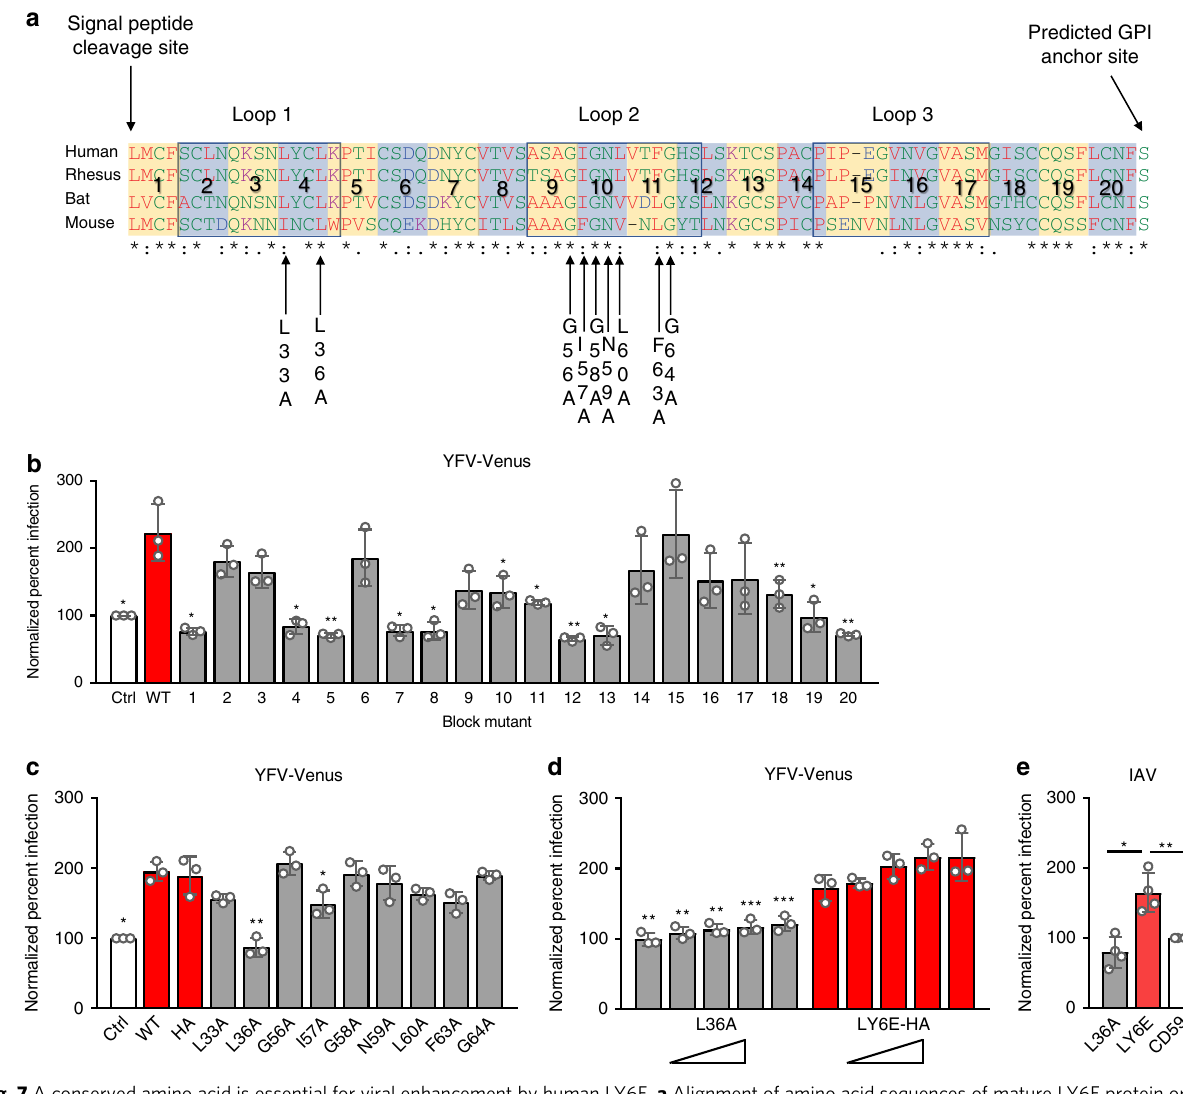
Fig. 7 A conserved amino acid is essential for viral enhancement by human LY6E. a Alignment of amino acid sequences of mature LY6E protein orthologs. Red residues (AVFPMILW): small and hydrophobic or aromatic (except Y); blue residues (DE): acidic; magenta residues (RK): basic (except H); green residues (STYHCNGQ): have hydroxyl, sulfhydryl, or amine groups (plus G). Hyphens (-) indicate absence of a residue presents in other sequences. Consensus symbols indicate the following: *(asterisk) indicates a single, fully conserved residue, :(colon) indicates conservation between groups of strongly similar properties, .(period) indicates conservation between groups of weakly similar properties. b STAT1 -/- fi broblasts expressing LY6E block mutants as shown in ( a ), WT LY6E, or fl uc control were infected with YFV-17D-Venus (0.33 MOI, 24 h, control average 33% infection). Infection is shown normalized to fl uc control. n = 3 biological replicates. c STAT1 -/- fi broblasts expressing HA-tagged LY6E point mutant clones as shown in ( a ), LY6E-HA, or fl uc control were infected with YFV-17D-Venus (0.25 MOI, 24 h, control average 16.4% infection). Infection is shown normalized to fl uc control. n = 3 biological replicates. d STAT1 -/- fi broblasts were transduced with fi ve volumes of lentivirus (twofold increase per dose) expressing LY6E(L36A)-HA, LY6E- HA, or fl uc control. Cells were infected with YFV-17D-Venus (0.25 MOI, 24 h, control average 24% infection). Infection is shown normalized to fl uc control (not shown) for respective lentivirus doses. n = 3 biological replicates. e STAT1 -/- fi broblasts expressing LY6E, LY6E (L36A), or CD59 were infected with IAV (A/WSN/33, 0.25 MOI, 8 h, control average 17.4% infection) and stained for NP. Infection is shown normalized to CD59 as a control. n = 4 biological replicates. * p < 0.05, ** p < 0.01, *** p < 0.001. SD is shown. b , c were analyzed before normalization by repeated measures one-way ANOVA with Greenhouse-Geisser correction followed by Dunnett ’ s multiple comparison test relative to WT LY6E. For d , ratio paired t -test was used to compare L36A and LY6E at equivalent doses of lentivirus prior to data normalization. Data for e were analyzed prior to normalization by repeated measures one-way ANOVA with Holm Sidak ’ s multiple comparison test relative to WT enhances infectivity by multiple viruses 45 – 48 , but is also essential for cellular antiviral immunity by contributing to dendritic cell (DC) maturation. Axl − / − mice are more susceptible to IAV and WNV infection, indicating that the defect in DC maturation overshadows the effects of viral hijacking 49 .